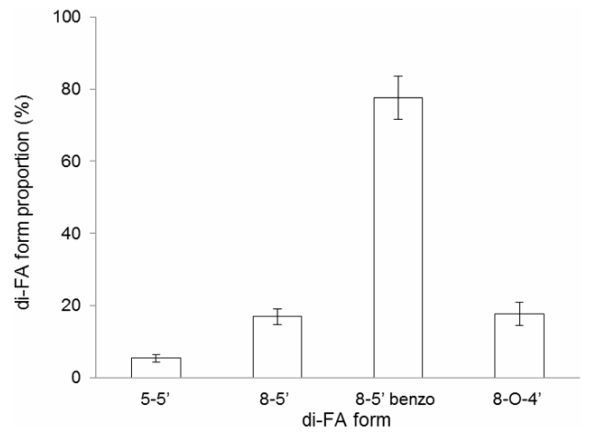
Figure 4. Di-FA form and proportion in WEAX gels.